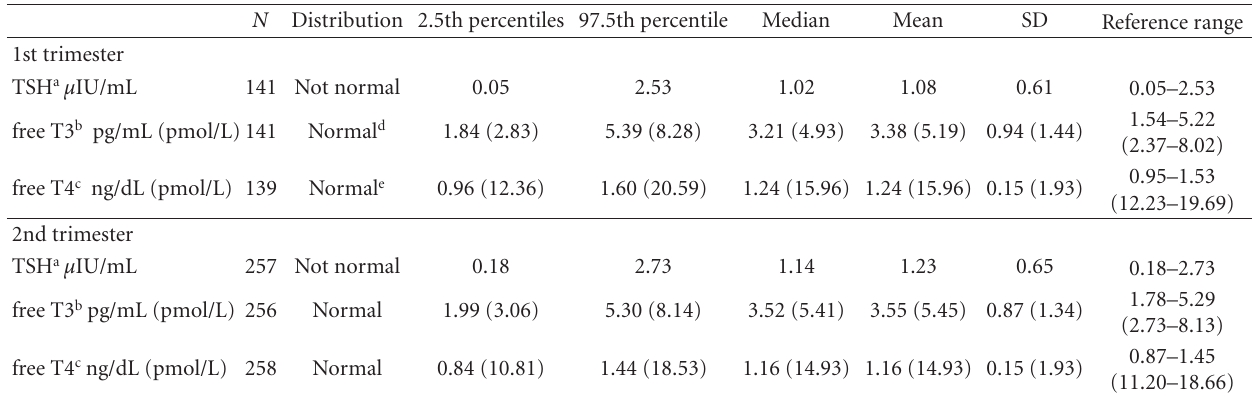
Table 2: Thyroid hormones according to gestational age, Rhea mother-child cohort, Crete, Greece.